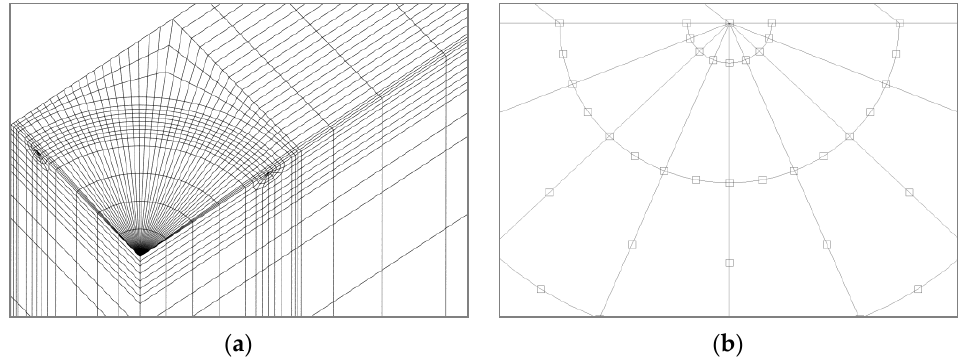
Figure 3. Mesh of the plate: ( a ) cracked surface, and ( b ) detail of the crack tip. The SIF in mode I ( K I ) was evaluated through the energy release rate ( G ). In the linear elastic regime and considering that the crack front is under plane deformation conditions (except for the points in contact with the plate outer surface), both parameters are related